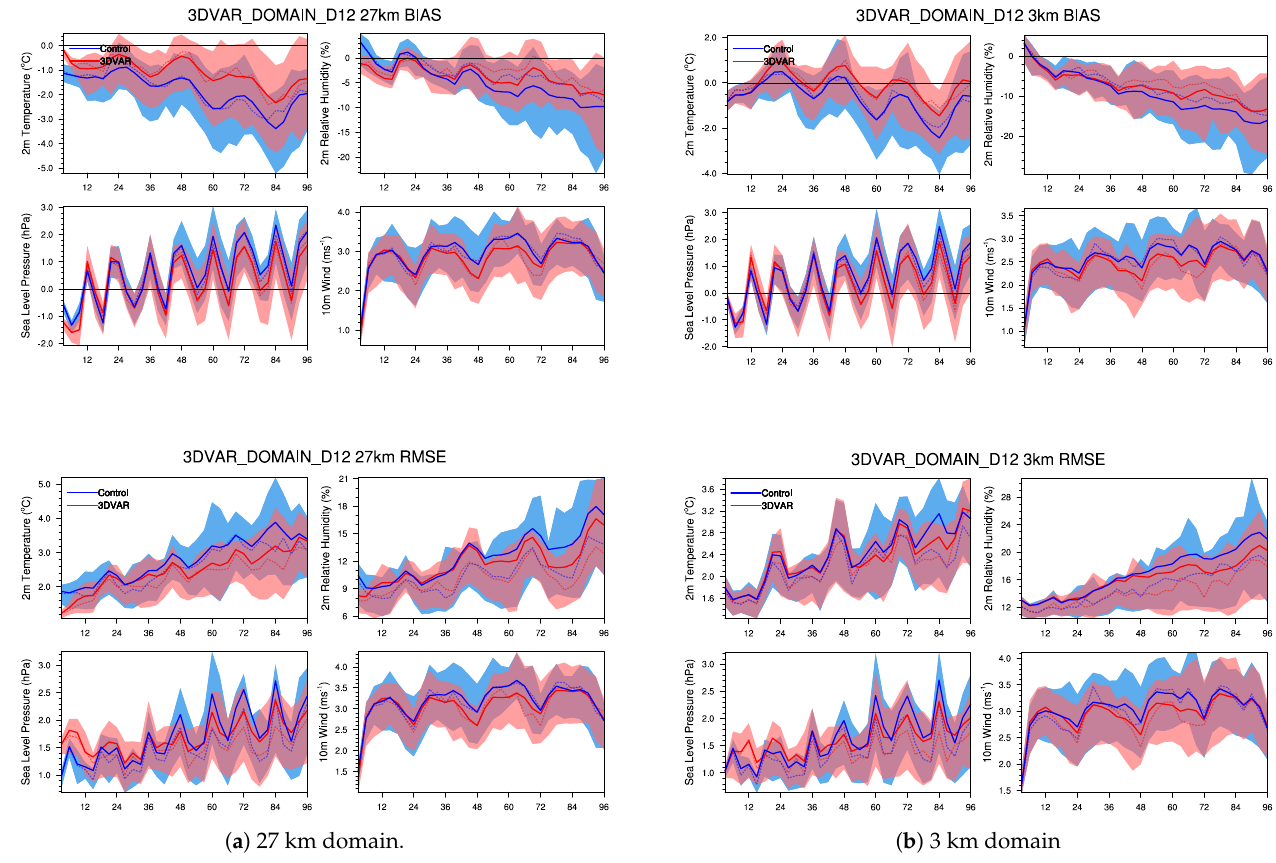
Figure 5. The BIAS station and the RMSE station statistics of 3DVAR_DOMAIN_D12 (red) comparing to the control case CONTROL_DOMAIN (blue) for the 27 km and 3 km domain. The solid lines represent the mean, the dotted lines represent the median and the shaded areas indicate the upper and lower quartile of the distribution. The statistics of the variables 2 m temperature, 2 m relative humidity, sea level pressure, and 10 m wind speed are